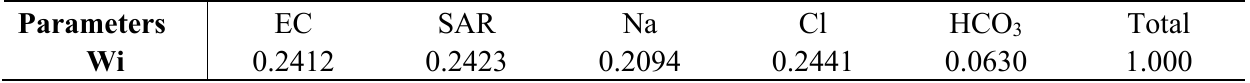
Table 6. Weights for the Water Quality Index (WQI) parameters.